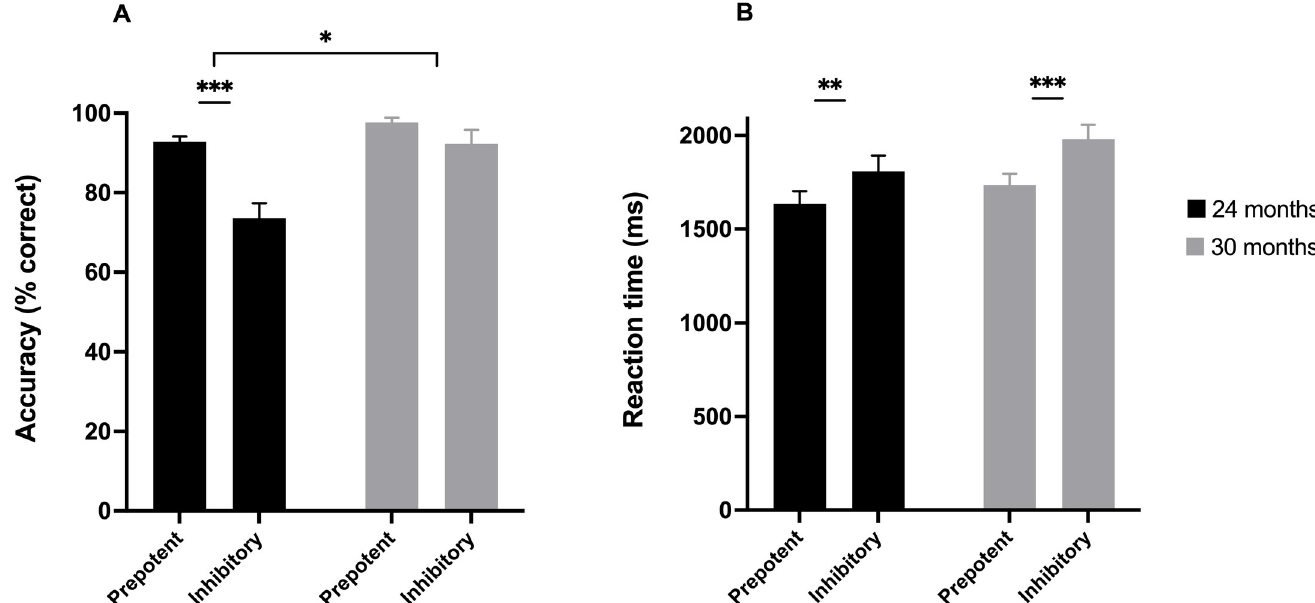
Fig 2. (A) Mean accuracy (% correct) and (B) mean median reaction time in milliseconds for inhibitory and prepotent trials in the Early Childhood Inhibitory Touchscreen Task at 24 and 30 months of age. The bracket at the top in Fig 2A indicates the significant cross-age comparison of mean accuracy difference (AccD) score. Error bars indicate the standard error. ��� p < .001, �� p < .01, � p <